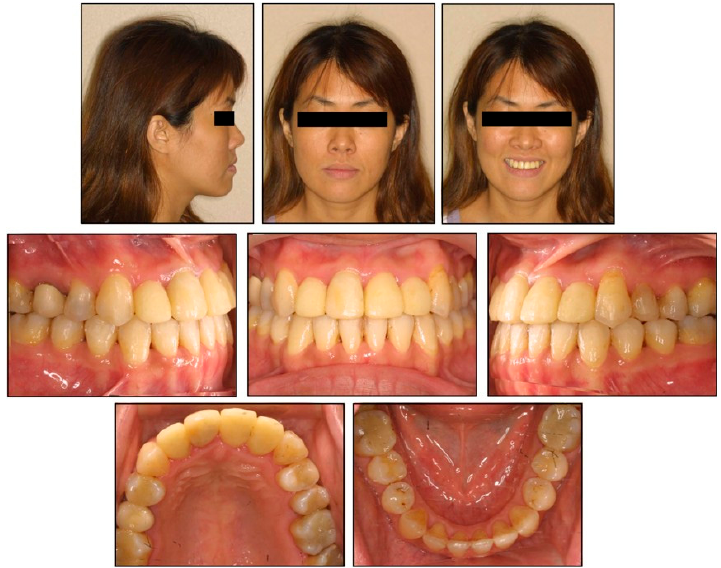
Figure 13. Case 2, Posttreatment facial and intraoral photographs.